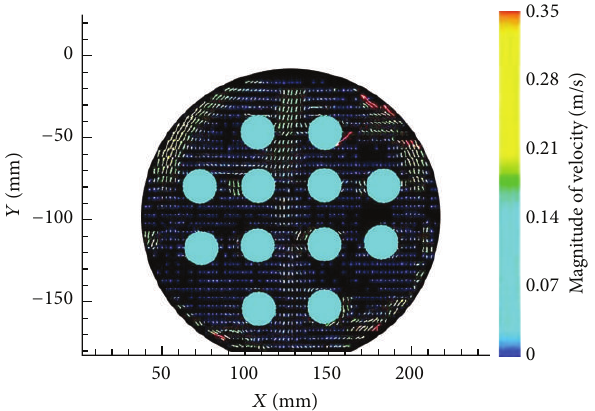
Figure 6: PIV and LIF system arrangement for the test facility of a 1/40 scaled-down moderator tank. Figure 7: Velocity field at the inlet nozzle center plane (inlet flow rate of 2.2 LPM).